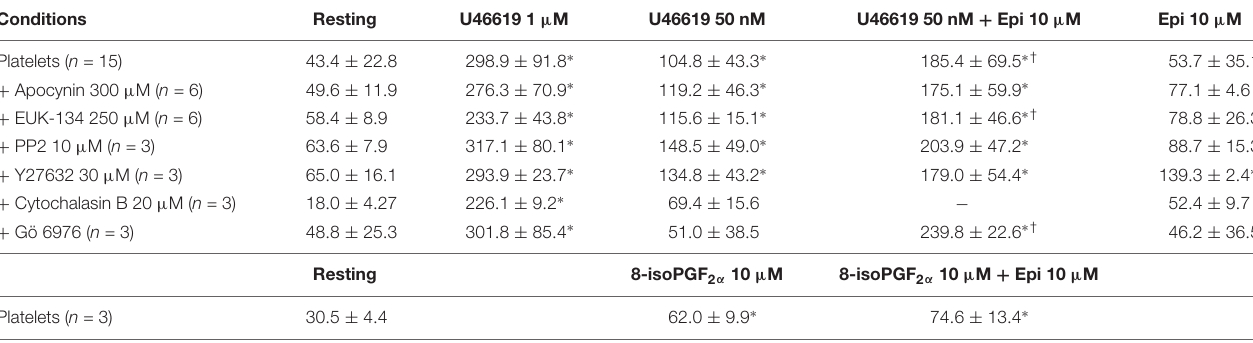
TABLE 4 | Maximal release of intracellular calcium (expressed in nM) in washed platelets (in the presence of ASA 100 µ M, apyrase 10 U mL − 1 , eptifibatide 10 µ g mL − 1 ) stimulated by U46619 1 µ M, U46619 50 nM, U46619 50 nM + epinephrine 10 µ M, epinephrine 10 µ M, 8-iso-PGF 2 α 10 µ M, 8-iso- PGF 2 α 10 µ M + epinephrine 10 µ